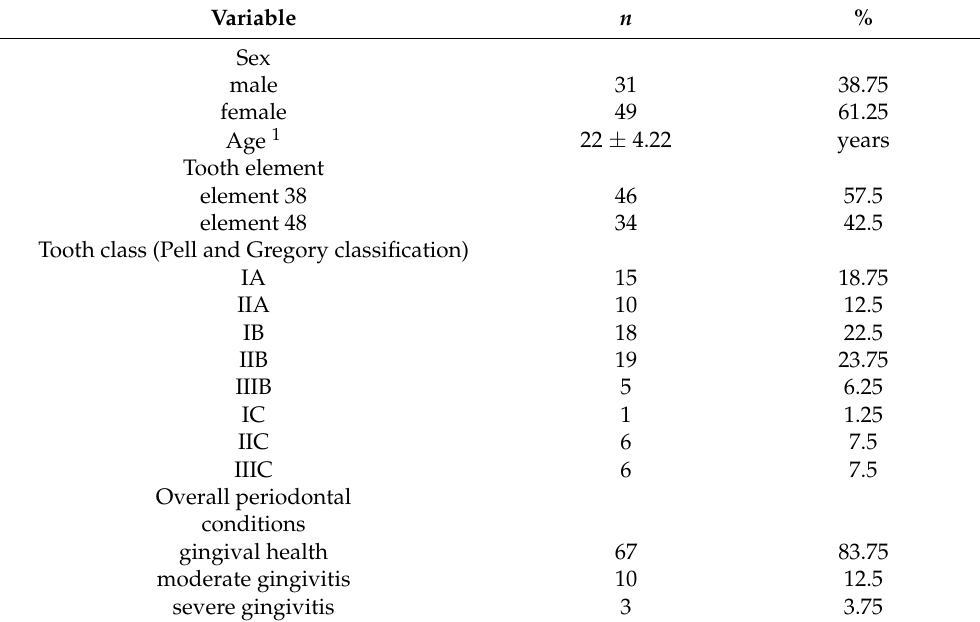
Table 1. Patients and tooth characteristics at